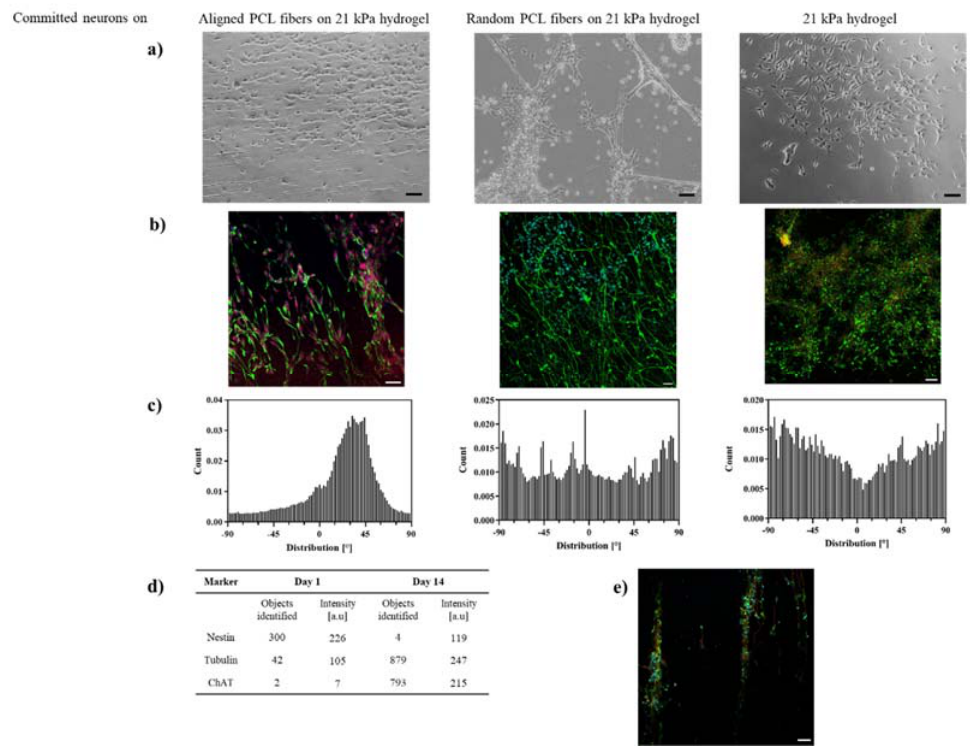
Figure 5. Alignment of committed neurons on PCL-gelatin scaffolds. ( a ) Optical micrographs and ( b ) confocal micrographs − immunostained with tubulin, nestin, ChAT and DAPI (green, yellow, red, blue) − of neurons on aligned, randomly distributed PCL-gelatin scaffolds and 21 kPa gelatin hydrogels at day 14; ( c ) Histograms of alignment of neurites on fiber-hydrogel scaffolds, number of cells N = 100; ( d ) Intensity analysis of nestin and tubulin of neurons on aligned PCL-gelatin scaffolds, number of images N = 9; ( e ) Neuro-bundle arrangement on aligned PCL-gelatin scaffolds, immunostained with tubulin, nestin, ChAT and DAPI (green, yellow, red, blue) at day 14, all scale bars = 100 μ m.